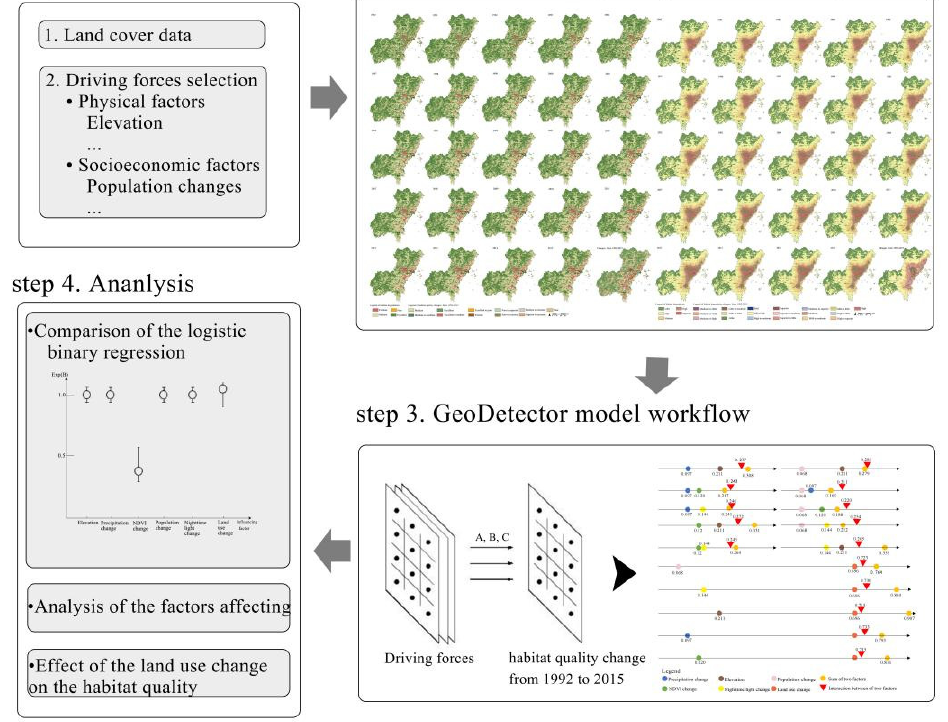
Figure 8. The specific working steps of this article.